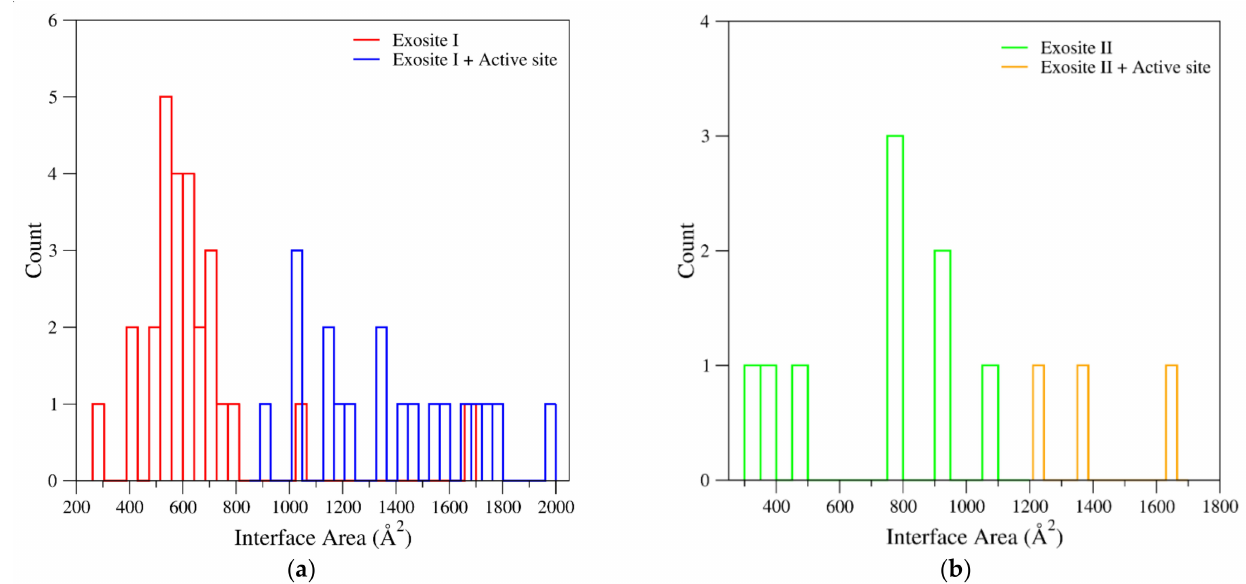
Figure 7. Distribution of the interface areas found in the thrombin-ligand complexes at ( a ) exosite I and ( b ) exosite II. In the panel ( a ), blue and red bars represent ligands bound either to both exosite I and active site or exclusively to the exosite. Similarly, in the panel ( b ), orange and green bars represent ligands bound either to both exosite II and active site or exclusively to the exosite. Structures of meizothrombin and prethrombin-2 were not considered. Only ligands corresponding to biomolecules (peptides/proteins, nucleic acids, and heparin-like compounds) bound to thrombin were analyzed. If multiple thrombin-ligand complexes were found in the PDB, the one refined at the highest resolution or the largest fragment was